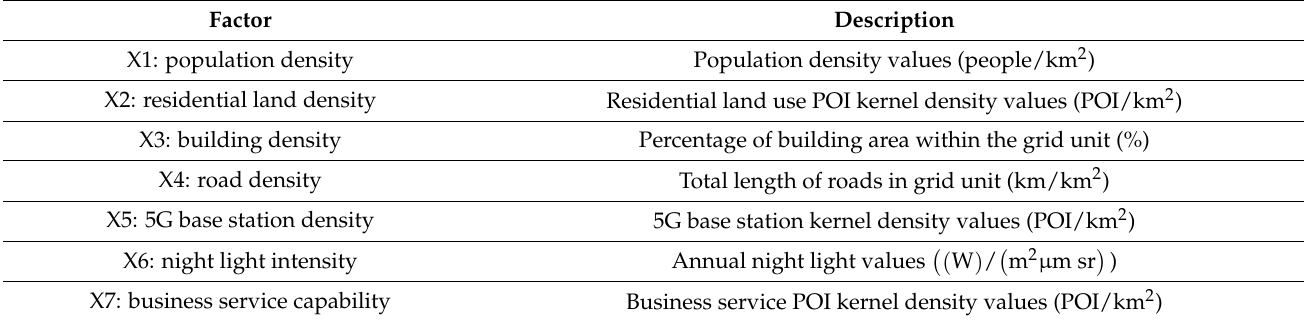
Table 1. An index system for detection results of spatial pattern of unmanned aerial vehicles (UAV) logistics network in